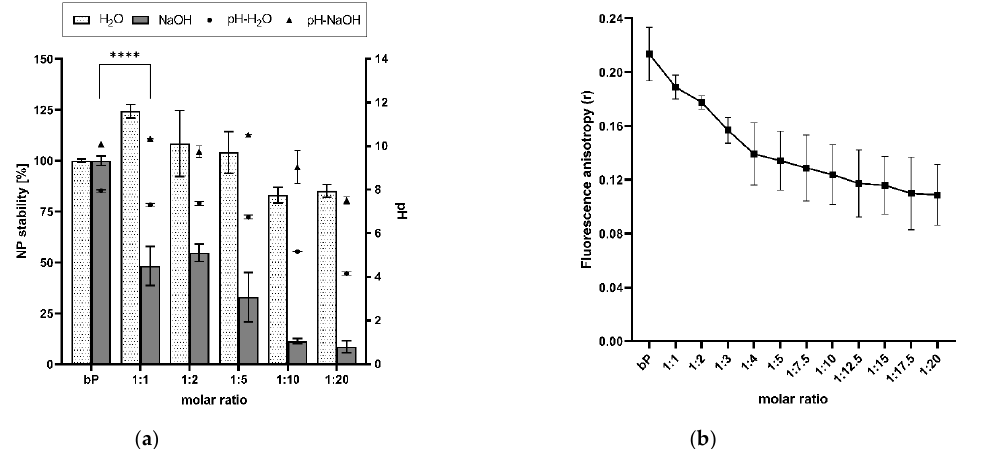
Figure 4. ( a ) Results of the NaOH stability assay and pH level evaluation. A highly significant (**** p < 0.001) reduction in nanoparticle stability was observed. With increasing citric acid concentrations, the pH decreased. ( b ) Fluorescence anisotropy (r) in correlation with increasing citric acid concentrations. Due to supplementation with citric acid, the anisotropy of the functionalized proticles decreased, which indicates a reduction in binding affinity between the microRNAs and the protamine-citric acid complex. The molar ratio refers to the molar protamine:CA ratio.